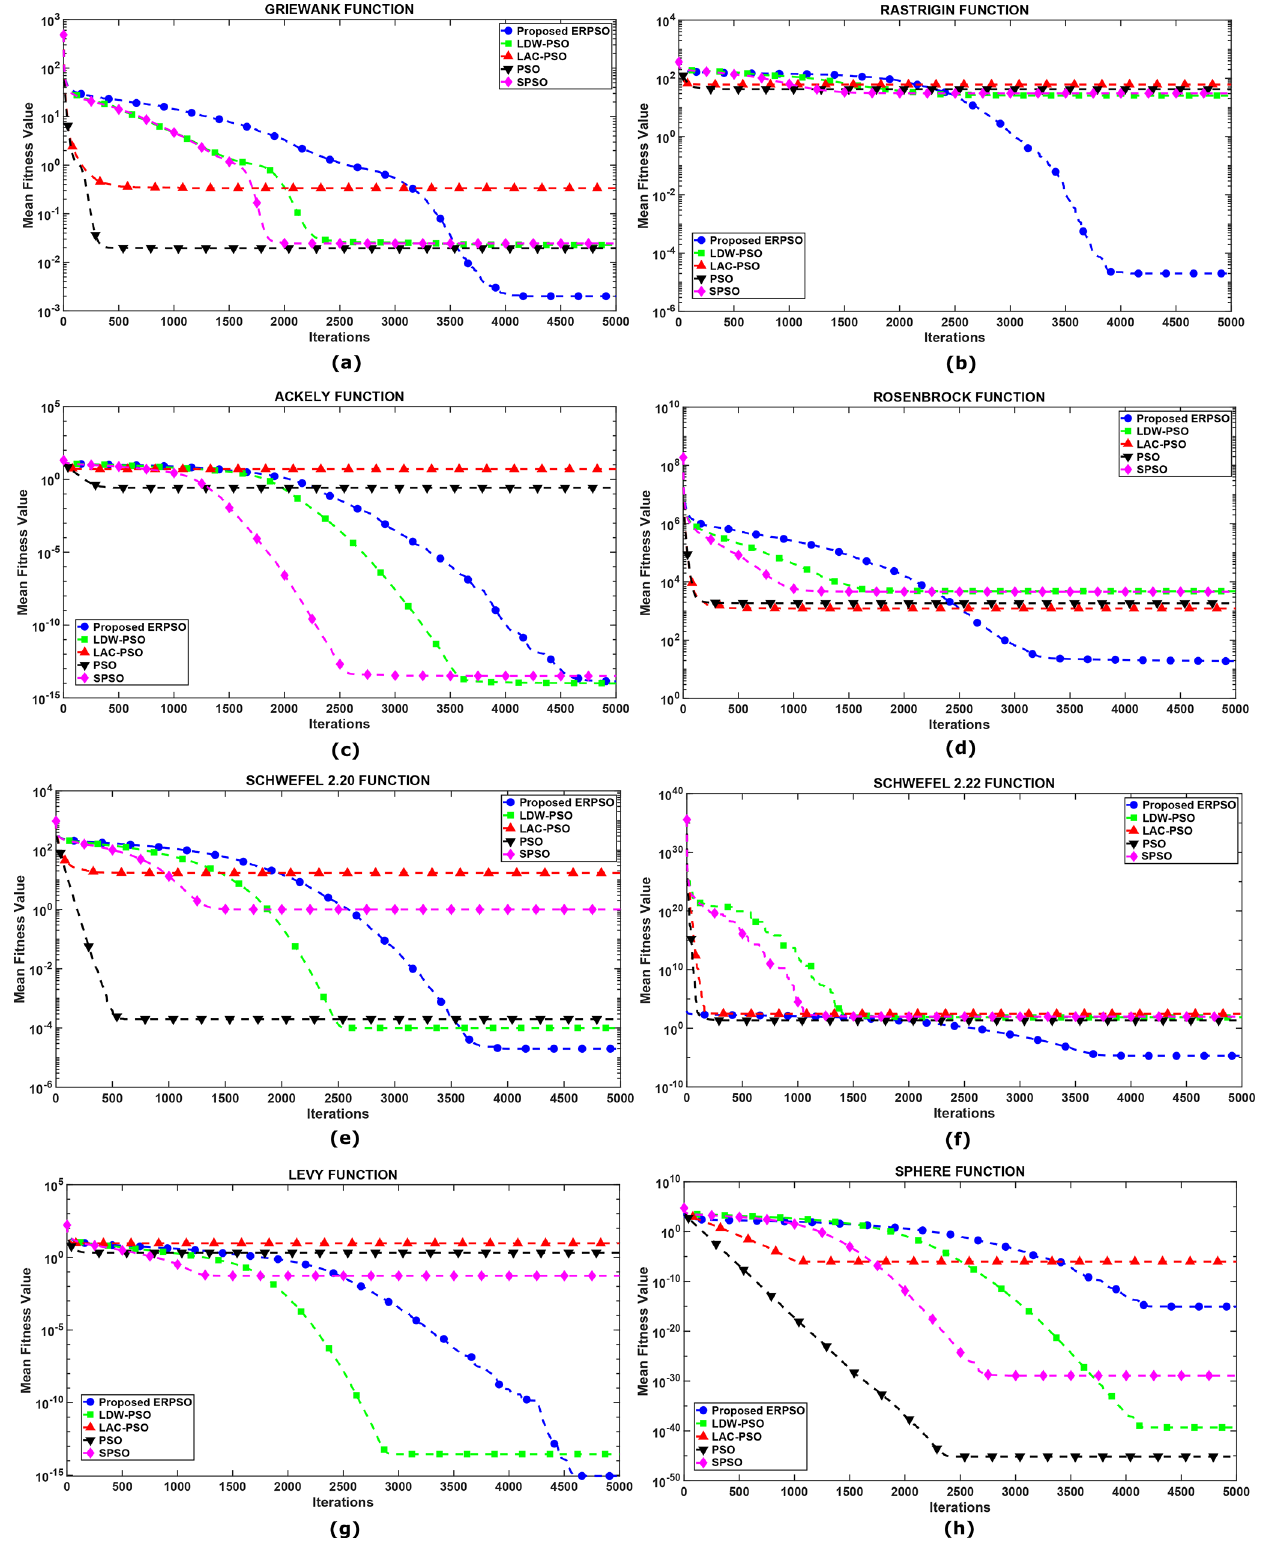
Figure 7. Optimization convergence curves for (a) Griewank function f 1 ( x ), (b) Rastrigin function f 2 ( x ), (c) Ackley function f 3 ( x ), (d) Rosenbrock function f 4 ( x ), (e) Schwefel 1.2 function f 5 ( x ), (f) Schwefel 2.22 function f 6 ( x ), (g) Levy function f 7 ( x ), and (h) Sphere function f 8 ( x